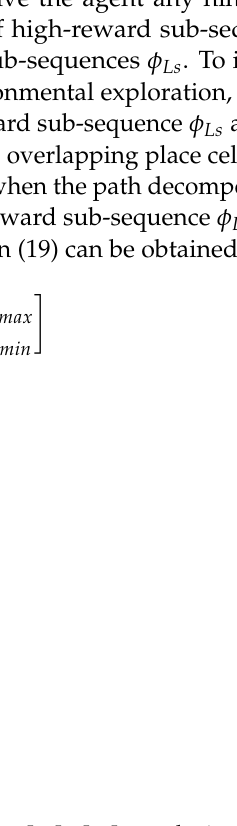
Figure 4. Schematic diagram of multiple intersections. I 1 , I 2 , I 3 , I 4 are the intersection points of the low-reward sequence φ L and the high-reward sequence φ H in different spatial locations respec- tively.